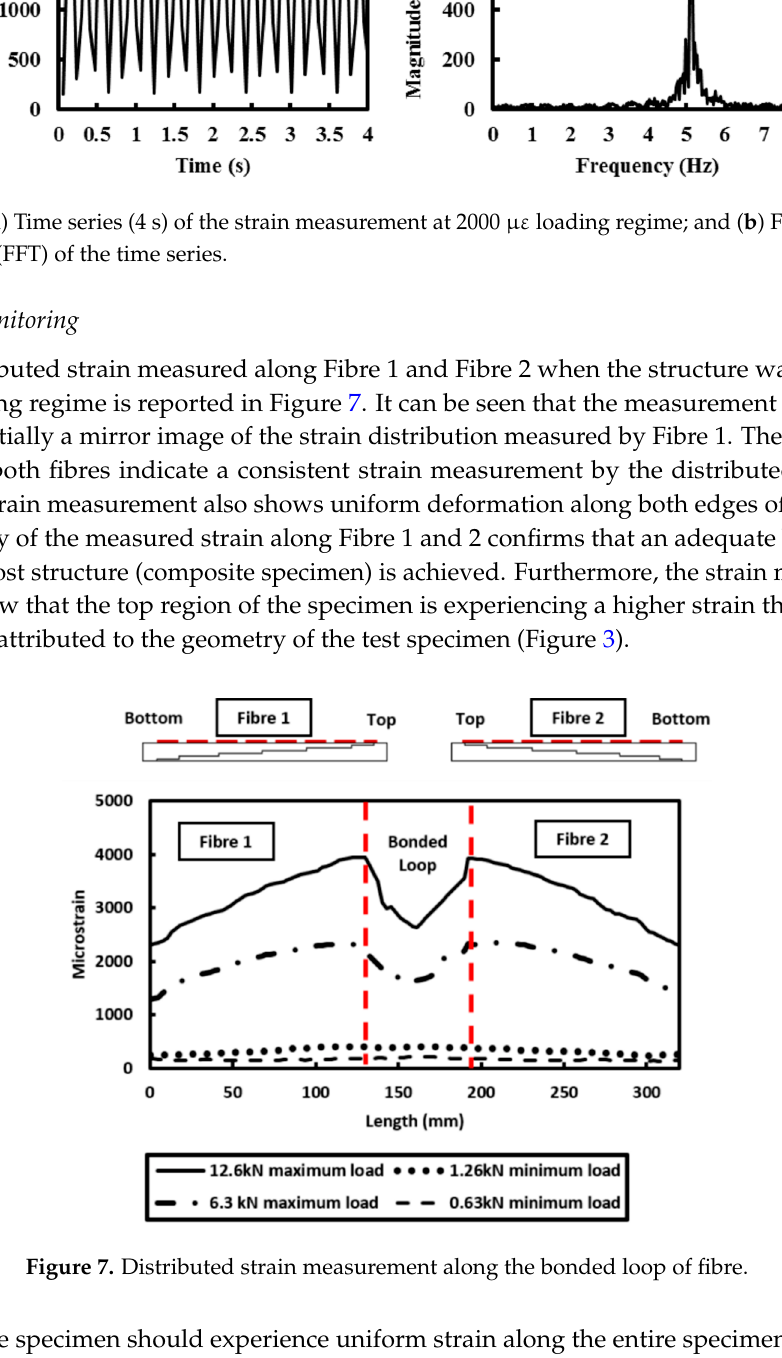
Figure 7. Distributed strain measurement along the bonded loop of fibre.